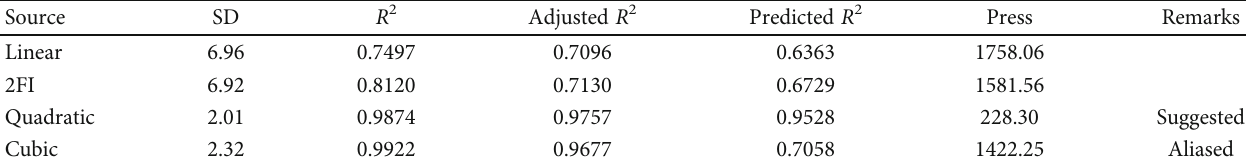
Table 7: Model summary statistics.